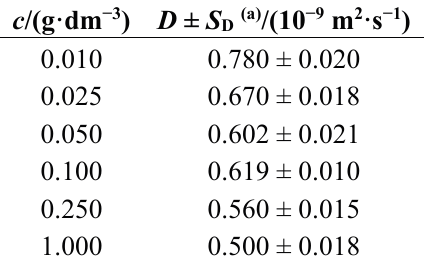
Table 3. Mutual diffusion coefficients, D , of NaHy in aqueous solutions at different concentrations, c, and the respective standard deviations, S D , obtained by the Taylor technique (by using carrier stream solutions of different concentrations) at T = 25 °C and at atmospheric